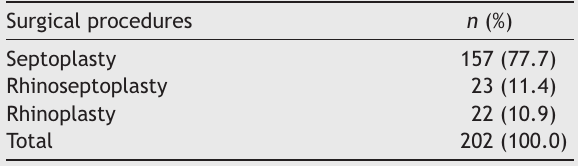
Distribution of surgical procedures